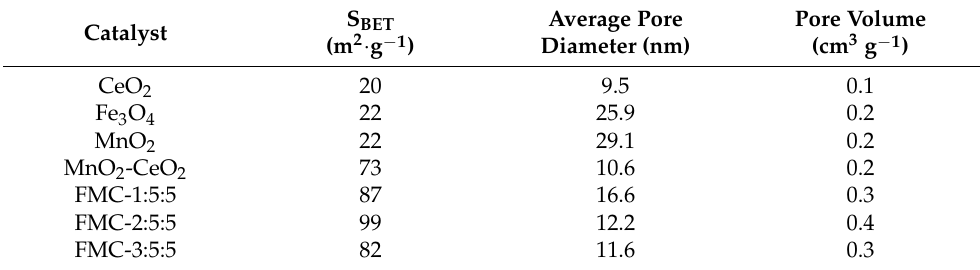
Table 1. Specific surface area, average pore diameter and pore volume of the catalysts.